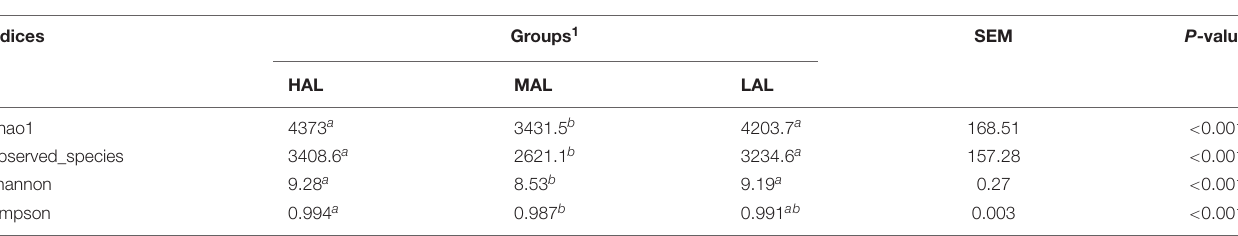
TABLE 2 | Effect of regions located at distinct altitudes on alpha diversity of yak rumen microbiota. Indices Groups